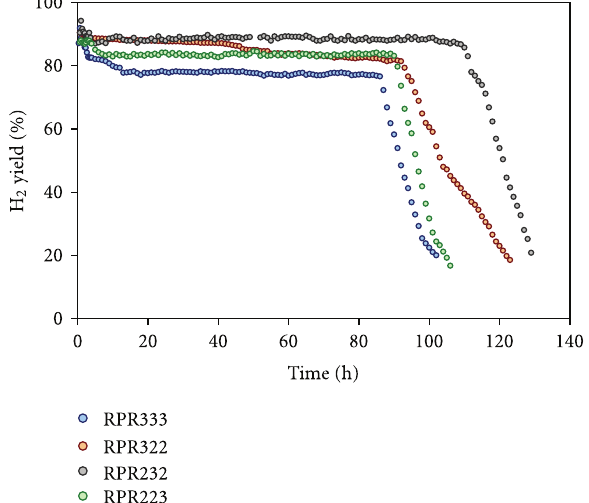
Figure 7: Performance of tri-metallic catalysts in terms of hydrogen